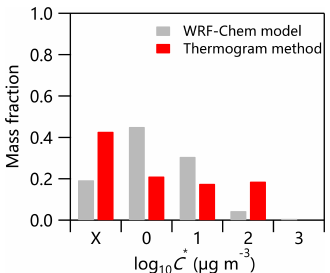
Figure 7. Volatility distributions of SOA estimated by WRF-Chem model and thermogram method in summer